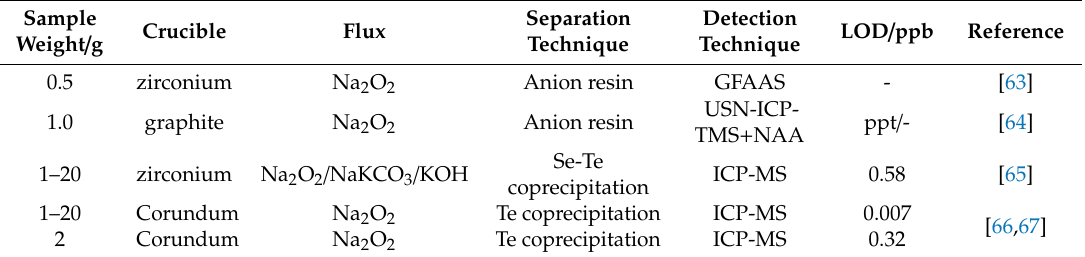
Table 2. A summary of various fusion digestion